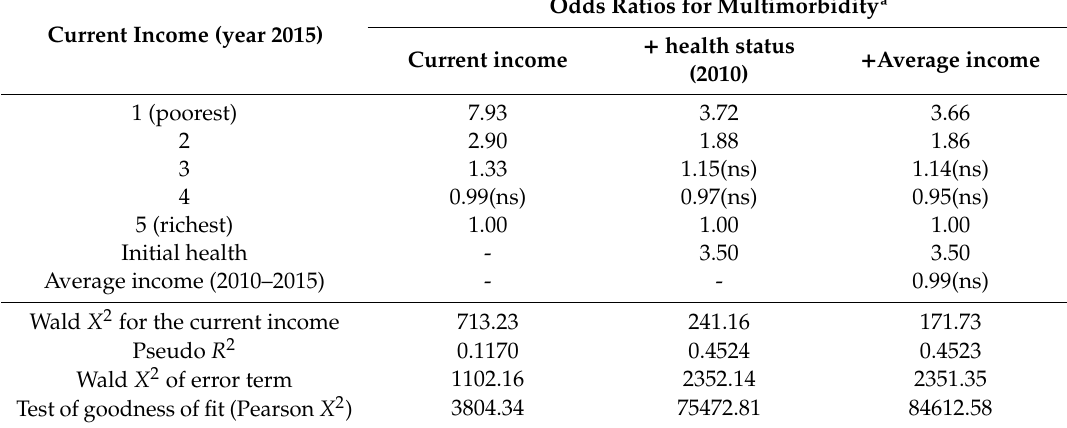
Table 2. E ff ect of a time dimension on the cross-sectional relation between current income and multimorbidity.